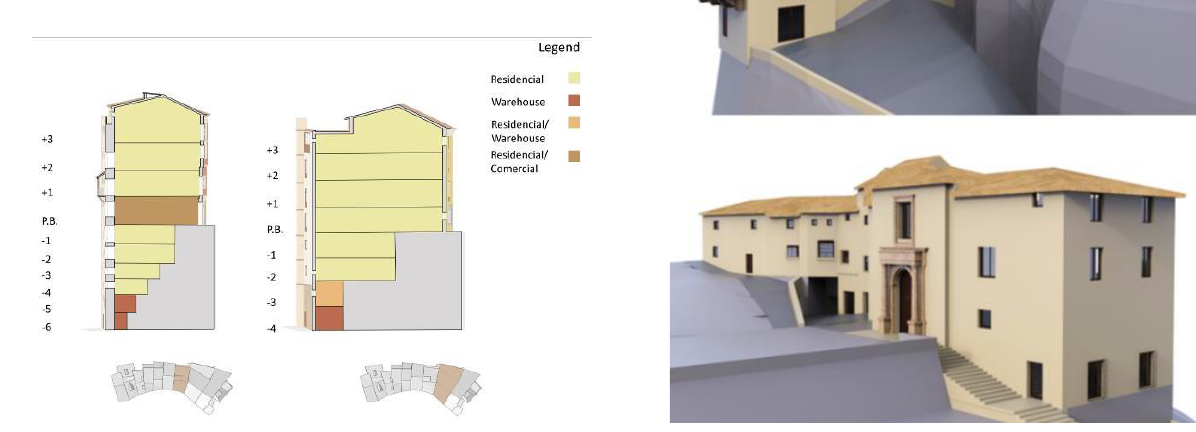
Figure 7. Skyscrapers - general 3D views.